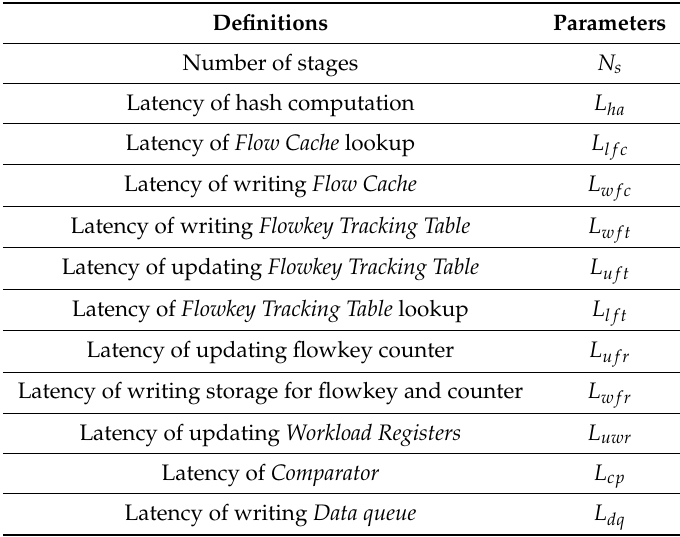
Table 1. Parameter